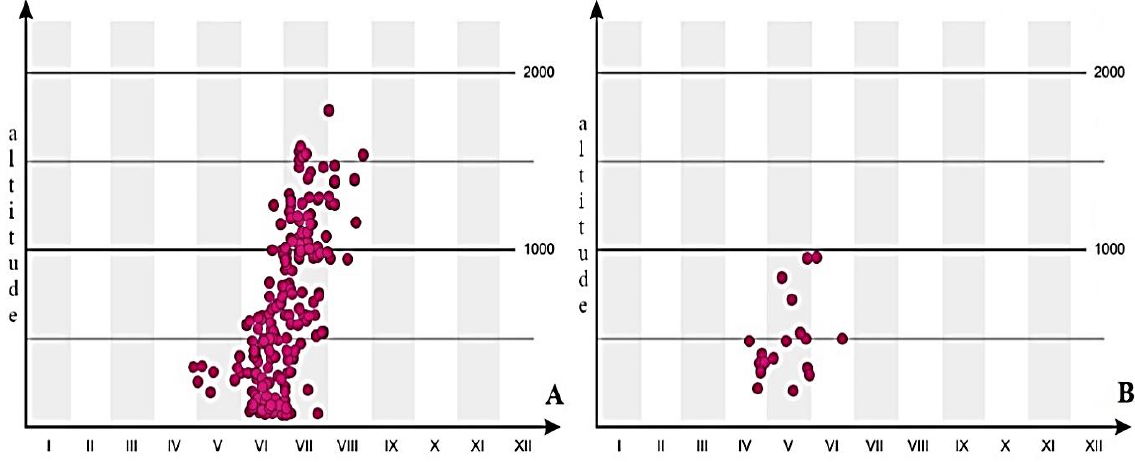
Figure 3. Data on distribution in Serbia by altitude (vertical axis) and months (horizontal axis). A − Libelloides macaronius (Scopoli, 1763); B − Libelloides lacteus (Brullé,